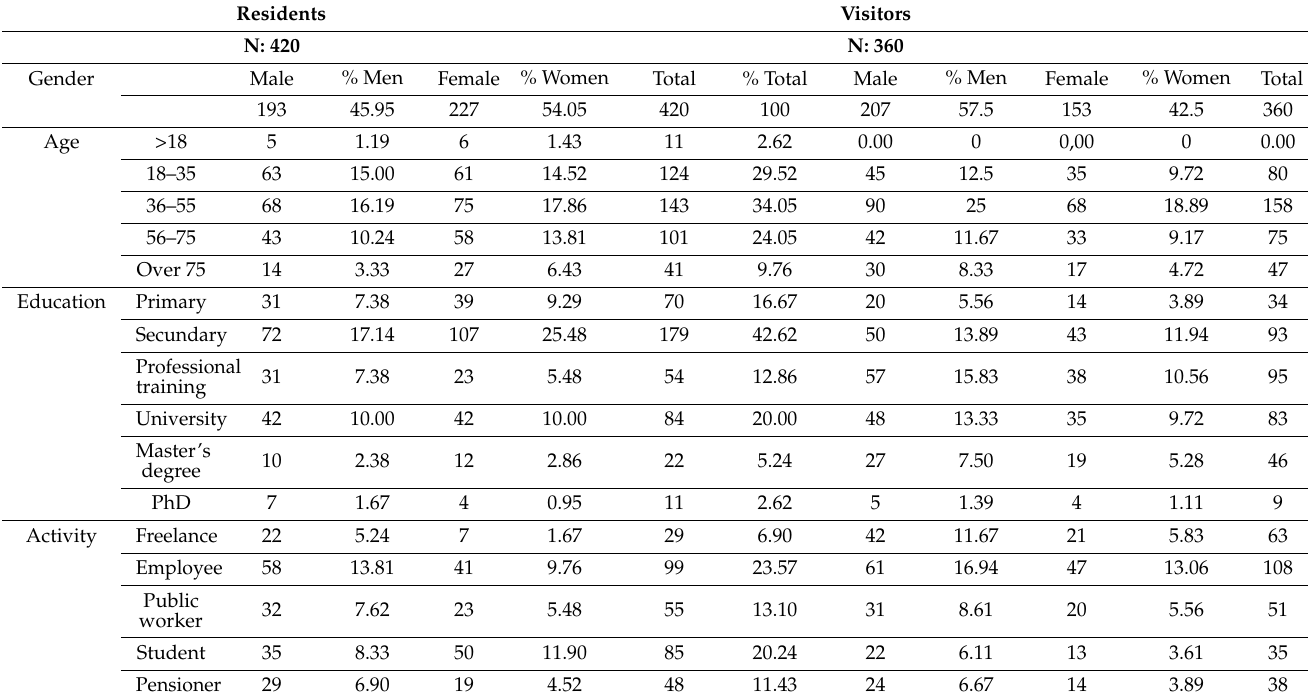
Table 2. Socio-demographic characterisation of the interviewees. Own